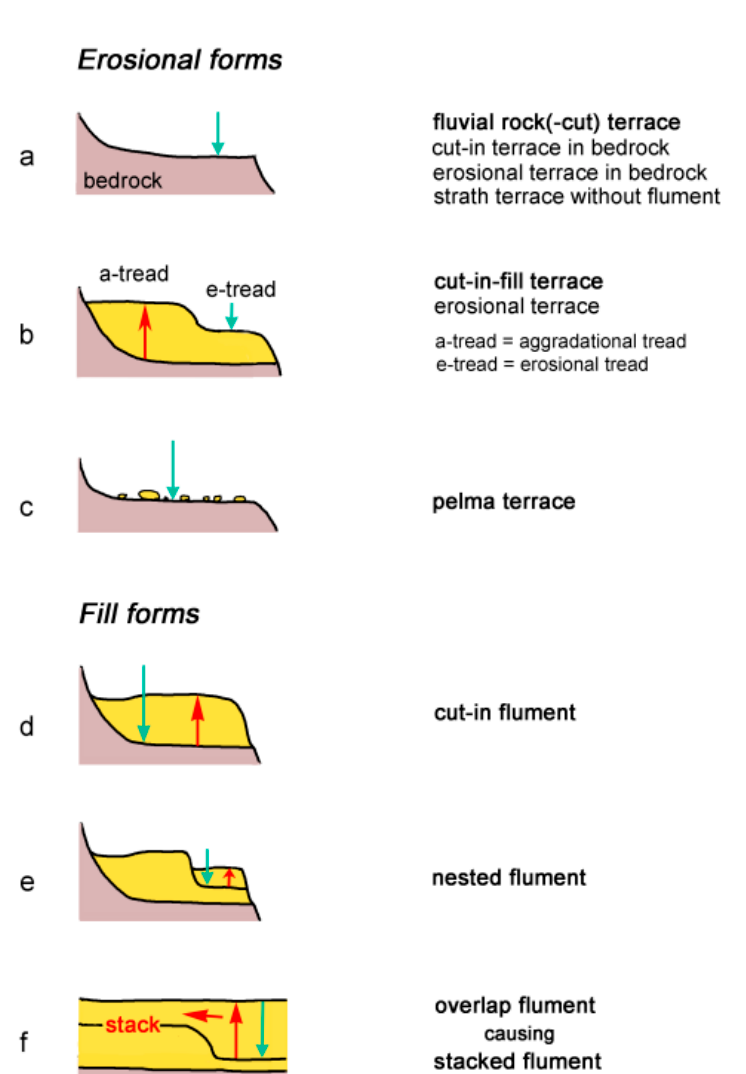
Figure 21. Terraces and fluments discussed in this paper. ( a ) Fluvial rock terrace; ( b ) Cut-in-fill terrace; ( c ) Pelma terrace; ( d ) Cut-in flument; ( e ) Nested flument; ( f ) Stacked flument.